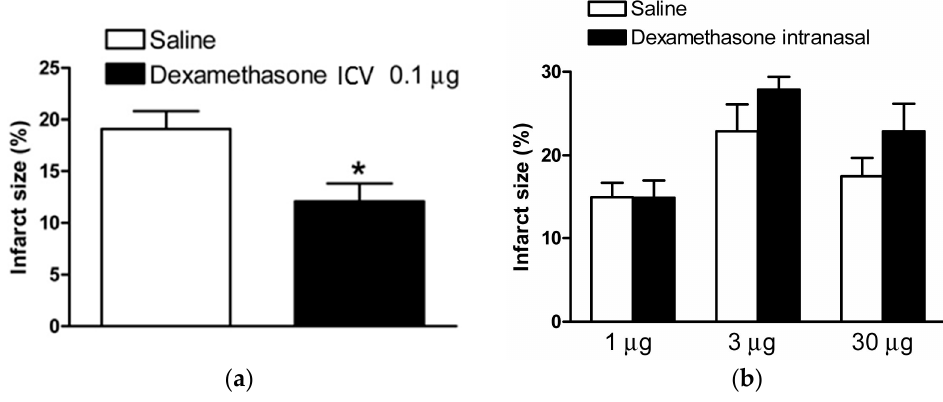
Figure 2. Dexamethasone treatment after HI injury. Dexamethasone via ICV injection or intranasal instillation administered 2 h after HIE insult. ( a ) Dexamethasone, 0.1 µg, ( n = 18) compared to saline control ( n = 20) via ICV injection significantly reduced brain infarct size in rat pups; and ( b ) no significant difference was seen when comparing dexamethasone, 1 µg, ( n = 14) vs. saline ( n = 17), 3 µg ( n = 8) vs. saline ( n = 8), or 30 µg ( n = 10) vs. saline ( n = 12) via intranasal administration. Data are means ± SEM, * p < 0.05.